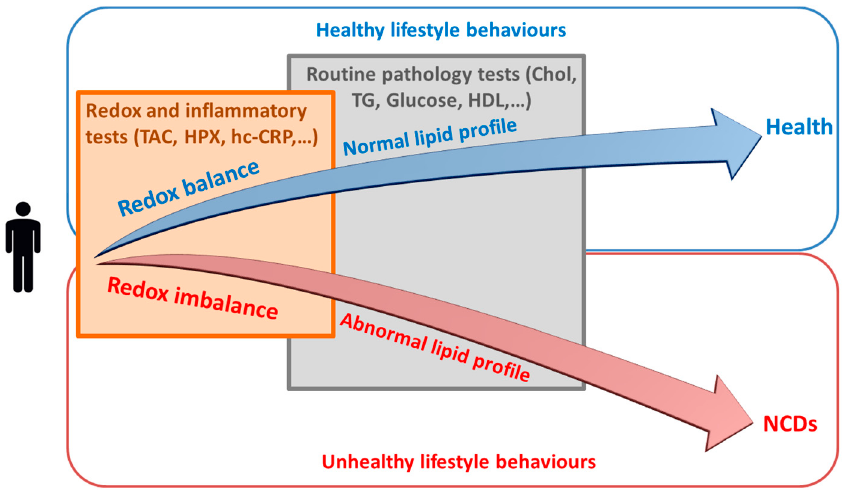
Figure 4. Assessment of redox state (i.e., assessment of the degree to which oxidative stress is present) as a possible approach for early distinction of whether various lifestyle behaviours are driving an individual toward health or toward development of disease-related pathologies. NCDs: non-communicable diseases; TAC: total antioxidant capacity; HPX: lipid hydroperoxides; hc-CRP: high sensitivity C-reactive protein; Chol: cholesterol; TG: triglycerides; HDL: high density lipoprotein.